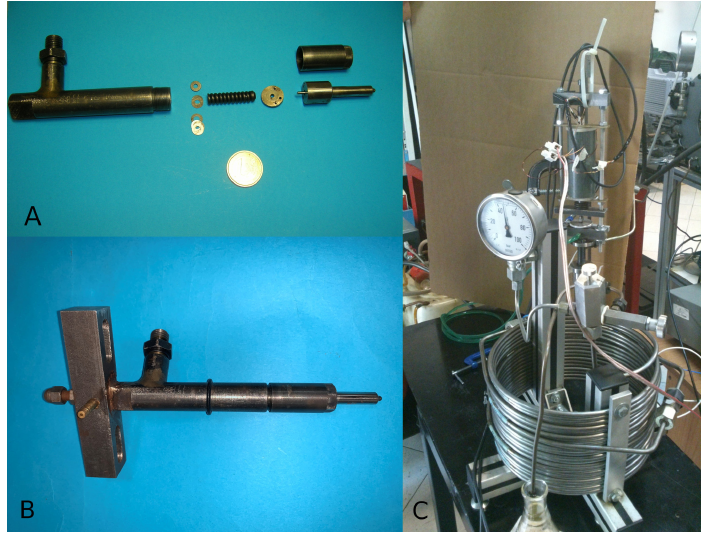
Figure 2. ( A ) The exploded structure of the commercial injector with a spring mechanism for the nozzle closure (1 € coin is shown as dimension reference); ( B ) the modified injector with iron bars and the steel rod that extends the original needle; ( C ) the experimental setup with the injector driven by the magnetostrictive actuator allocated on the Bosch tube for the fuel injection rate